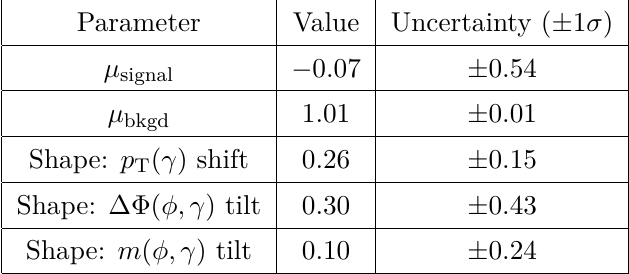
Figure 7 . The m ( φ, γ ) distribution of simulated γ + jet events overlaid with the result of a binned maximum likelihood fit using the method described in section 2 to derive the background PDF.